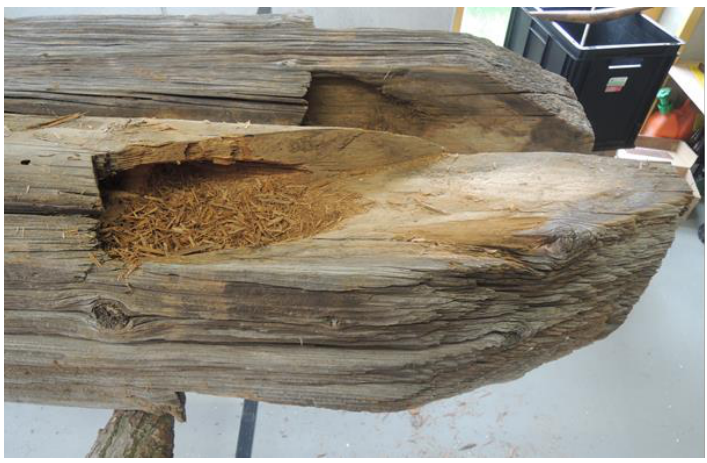
Figure 23. Damage to the beam (I2) in the location of the dovetail joint.